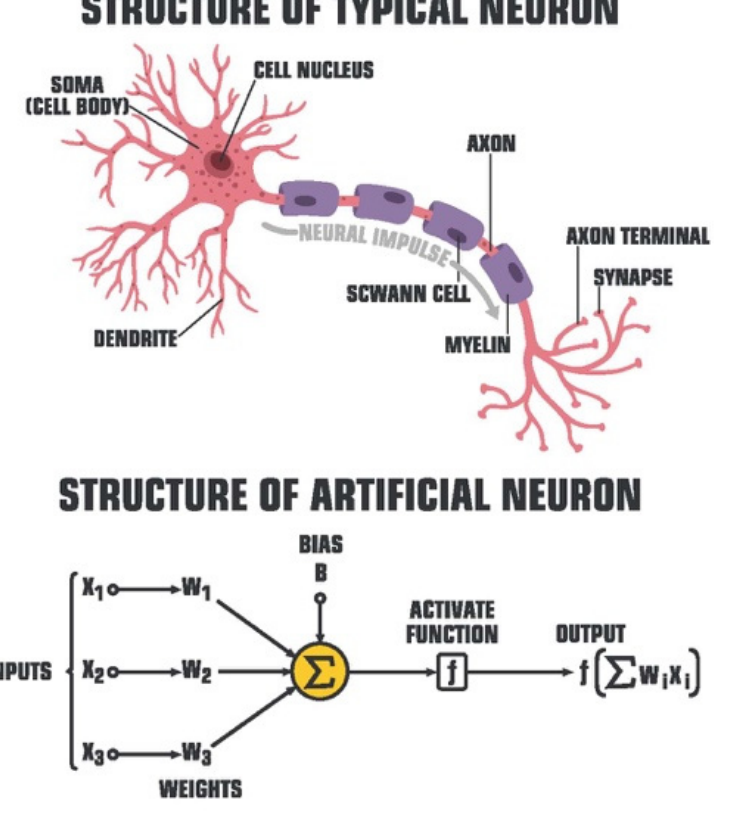
Figure 3. Artificial Neuron Model (ShadeDesign/Shutterstock.com, accessed on 27 April 2022). Powerful neural networks contain up to millions of nodes arranged in layers includ- ing input layers, hidden layers, and output layers (Figure 4).